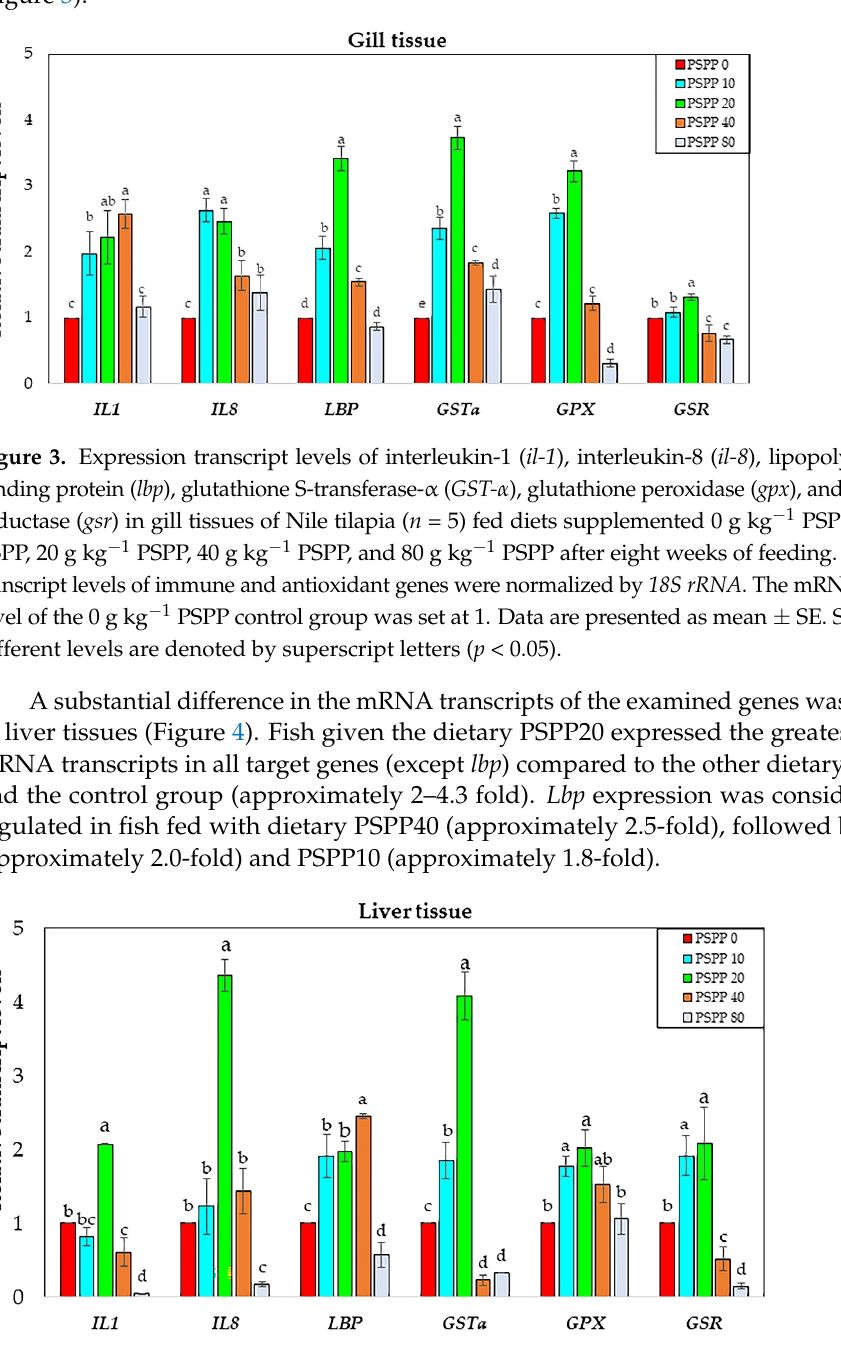
Figure 2. Lysozyme ( A ) and peroxidase ( B ) activity in the serum of Nile tilapia after four and eight weeks of feeding with experimental diets: 0 g kg − 1 (PSPP0) control, 10 g kg − 1 (PSPP10), 20 g kg − 1 (PSPP20), 40 g kg − 1 (PSPP40), and 80 g kg − 1 (PSPP80) cultivated for eight weeks. Data are presented